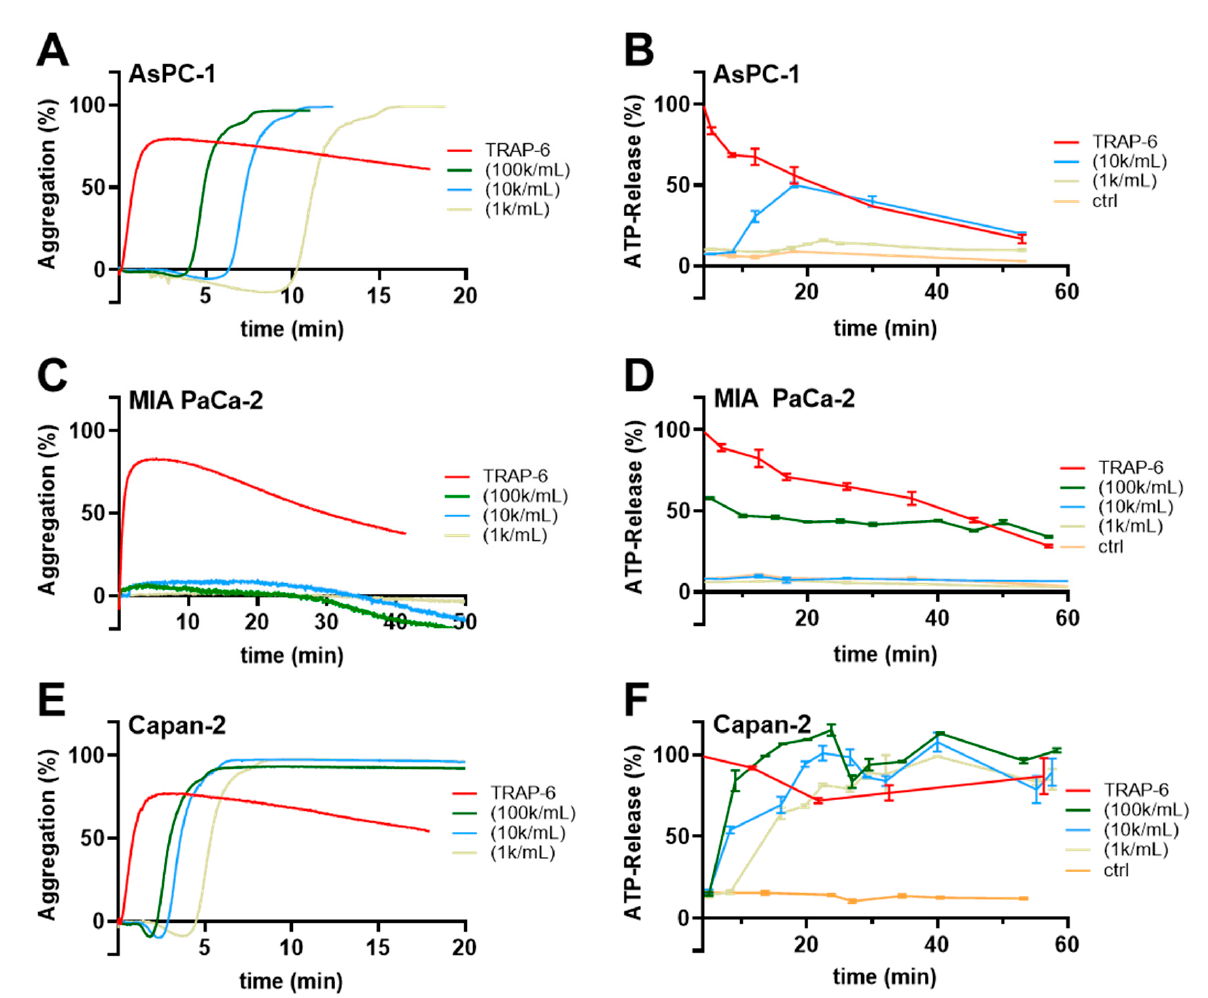
Figure 1. Pancreatic cancer cell induced human platelet aggregation and ATP secretion. Representative traces showing platelet aggregation in response to increasing concentrations of AsPC-1 ( A ), MIA PaCa-2 ( C ), Capan-2 ( E ) pancreatic cancer cells, or TRAP-6, respectively, for 20–50 min ( n = 5). ( B ) Quantification of ATP release from resting platelets, platelets activated with TRAP-6, or co-incubated with AsPC-1 ( B ), MIA PaCa-2 ( D ), Capan-2 ( F ) pancreatic cancer cells for 60 min using a luciferin-based ATP-determination kit ( n = 5).